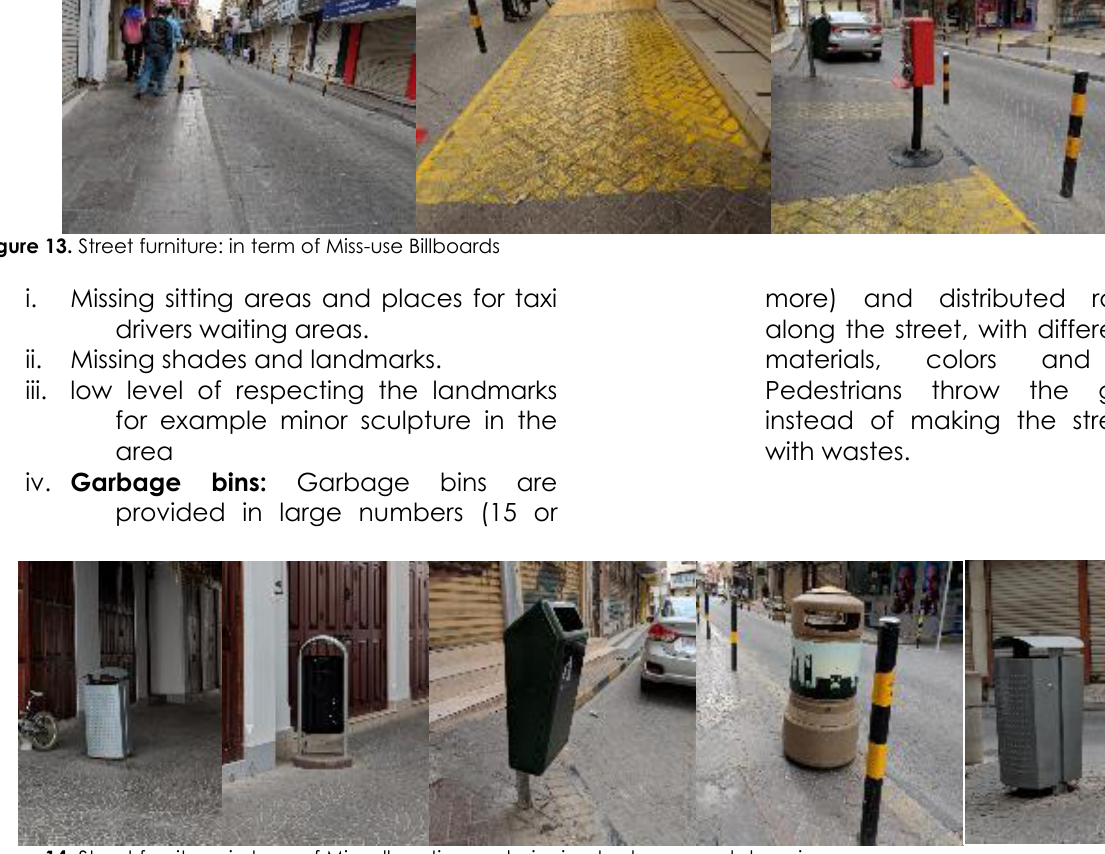
Figure 14. Street furniture: in term of Miss allocating or designing trashcans and dumping areas v. Fences and Barriers: Lots of barrier